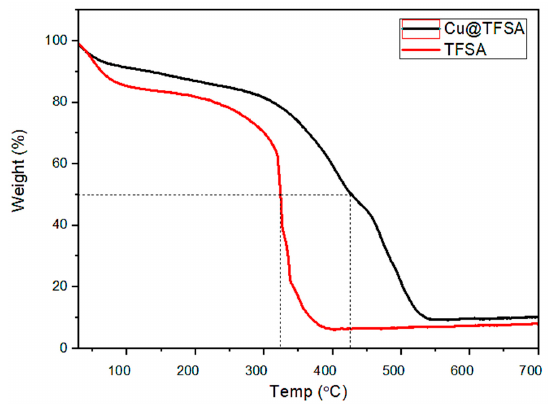
Figure 4. Thermogravimetric analysis of AC before and after Cu 2+ adsorption. The specific surface areas of TFSA and Cu@TFSA were 0.0150 m 2 /g and 0.3109 m 2 /g,